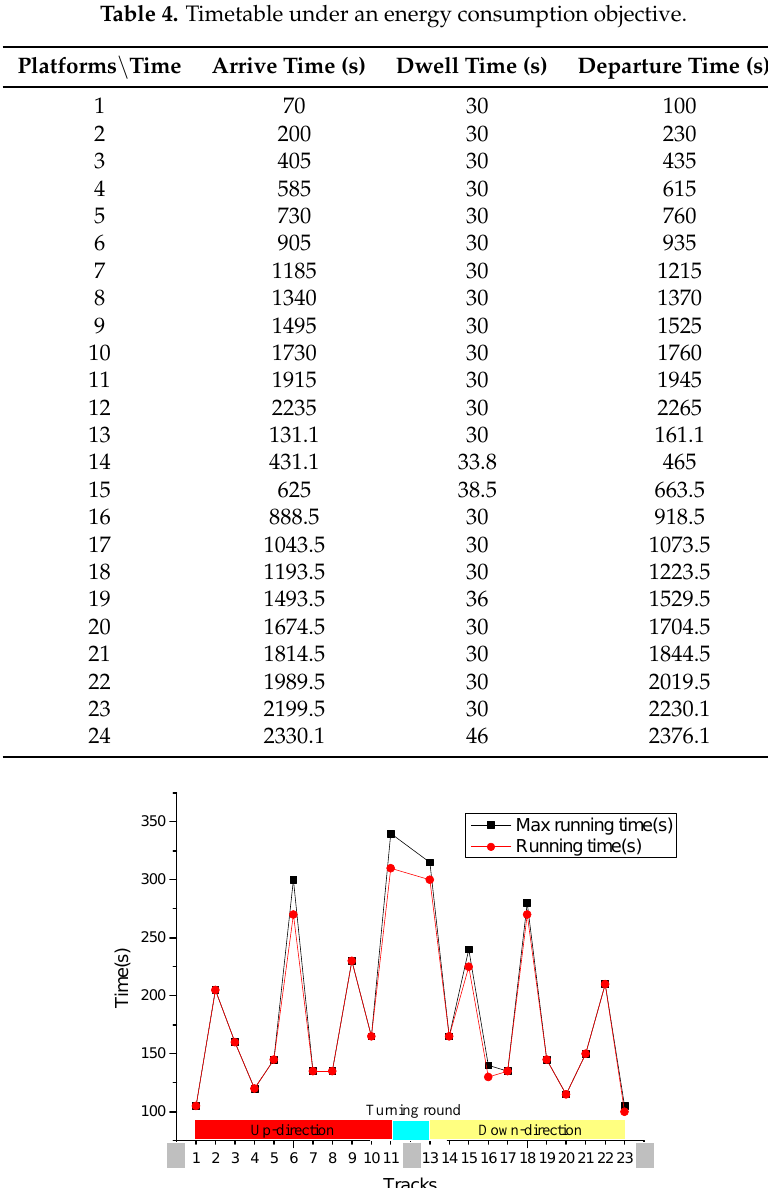
Table 4. Timetable under an energy consumption objective.